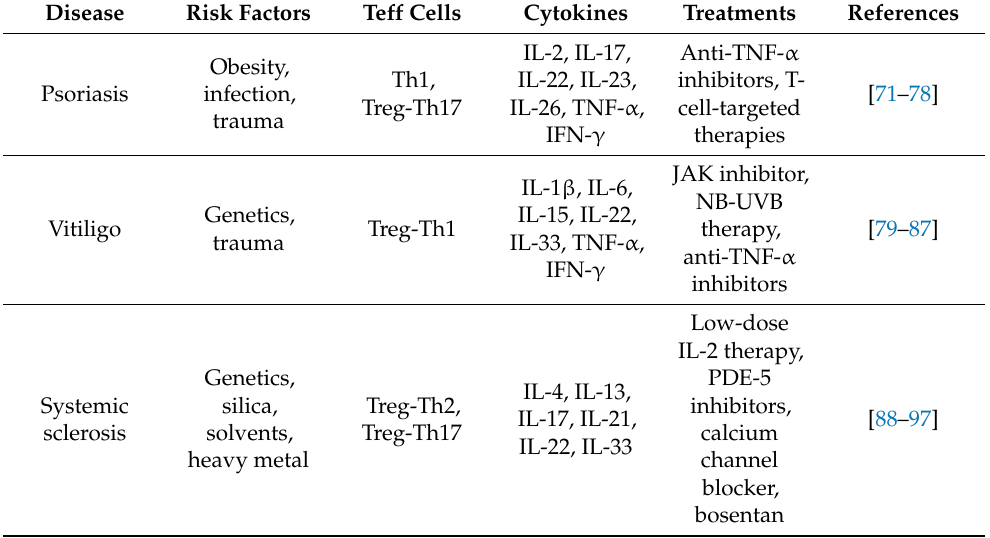
Table 1. Table summarizes the key effector cells, cytokines, reported and proposed treatments, and risk factors of select cutaneous autoimmune diseases. IL, interleukin; Th, T helper; Treg, T regulatory; TNF- α , tumor necrosis factor alpha; IFN- γ , interferon gamma; PDE-5 = phosphodiesterase 5; JAK, Janus kinase; and NB-UVB, narrowband ultraviolet B.2.3. Disease Risk Factors Teff Cells Cytokines Treatments